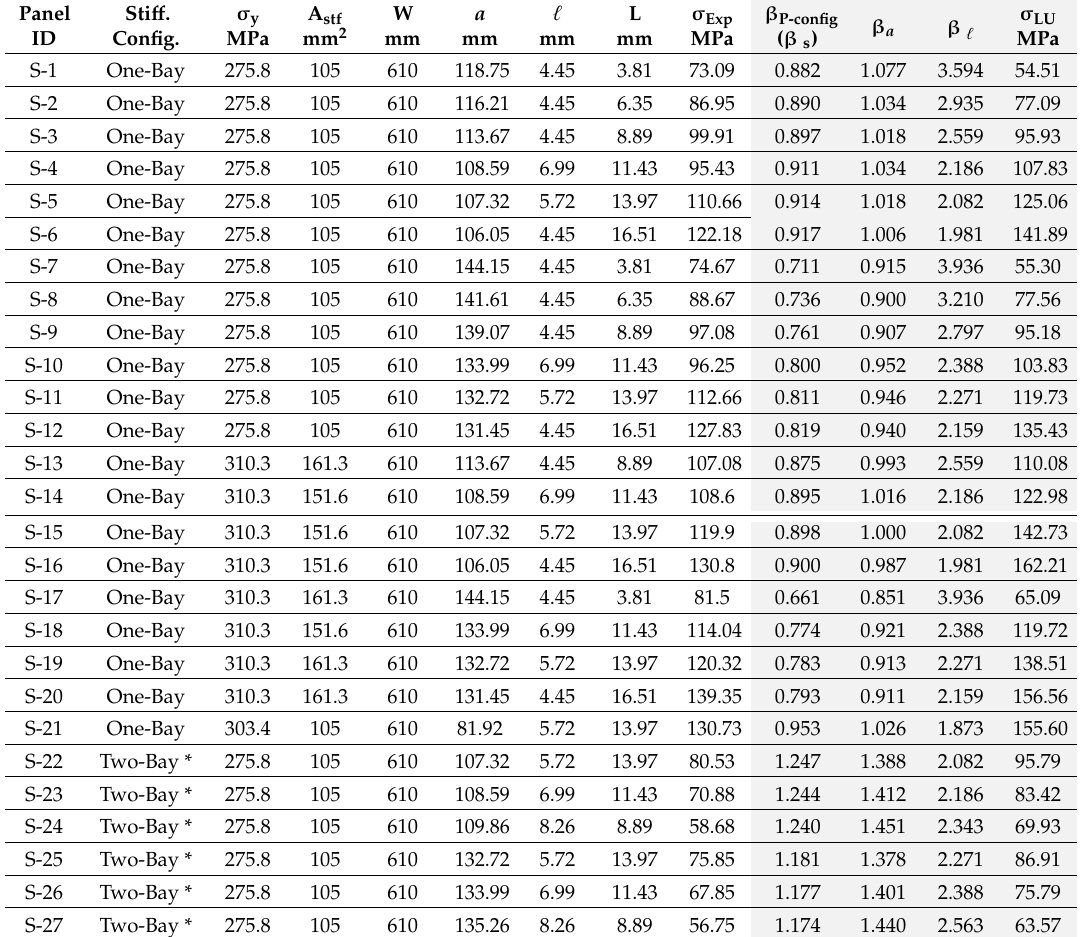
Table A2. Datasets for the sti ff ened 2024-T3 panels (experimental data and calculated assistance parameters)